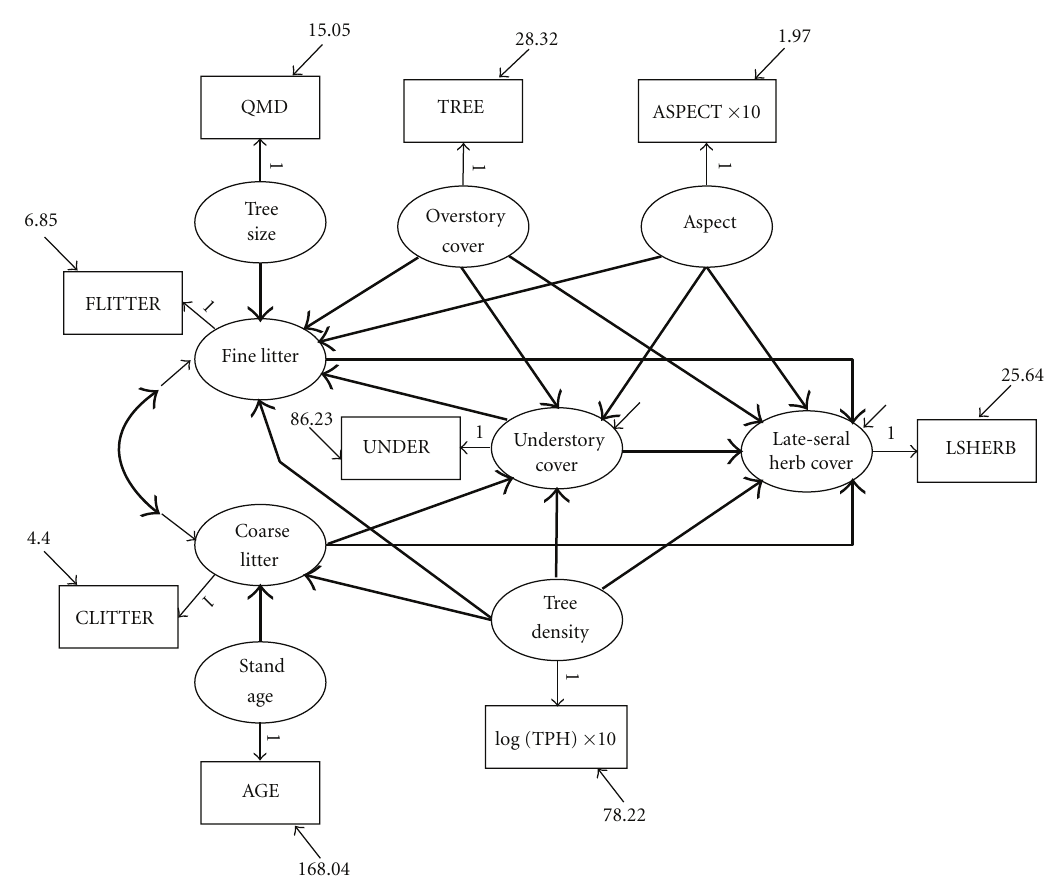
Figure 3: An SR model for the overstory-understory relationship in mature Douglas-fir forests. The exogenous latent variables (and associated observed variables) are (1) aspect (ASPECT × 10), (2) overstory cover (TREE), (3) tree size (QMD), (4) stand age (AGE), and (5) stand density (ln(TPH) × 10). The endogenous latent variables (and associated observed variables) are (1) fine litter (FLITTER), (2) coarse litter (CLITTER), (3) understory cover (UNDER), and (4) late-seral herb cover (LSHERB). All factor loadings are fixed at a value of 1.0. Measurement errors are fixed with a priori values as depicted by the numerical values with arrows pointing towards the observed variables. Arrows pointing towards the endogenous latent variables depict errors of the variables. Single arrowheads linking two latent variables depict direct e ff ects and the double arrowheads depict correlation between errors of fine litter and coarse litter latent variables.